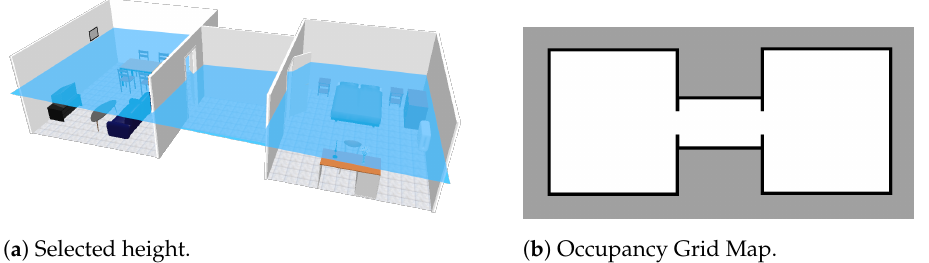
Figure 10. Creation of an occupancy grid map from point cloud data: ( a ) initial scenario with ceiling and frontal walls removed to allow the view of its interior, ( b ) selected height at which the point cloud data are collected, marked with a horizontal blue